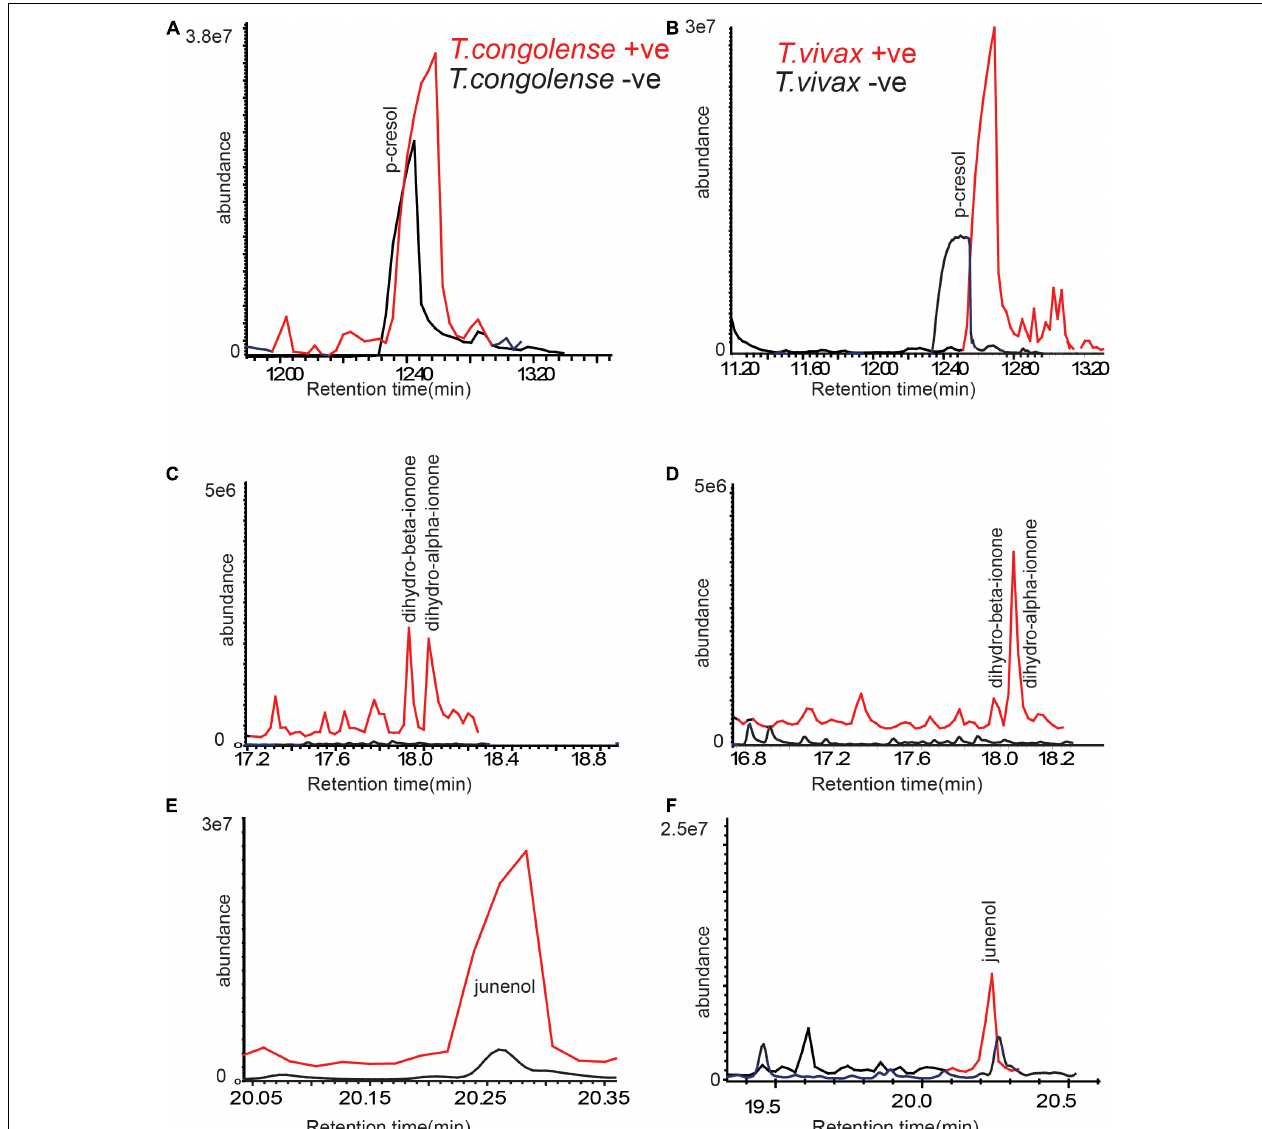
FIGURE 6 | Trypanosome-induced and modified metabolites are conserved in naturally infected cattle urine. (A,C,E) Representative GC-MS profiles of trypanosomosis biomarkers in urine of naturally T. congolense , (red line) infected cow as compared to healthy cow (black line) and (B,D,F) for T. vivax . Given the variation of metabolites modification between individual livestock, the graphs are not presented at the same